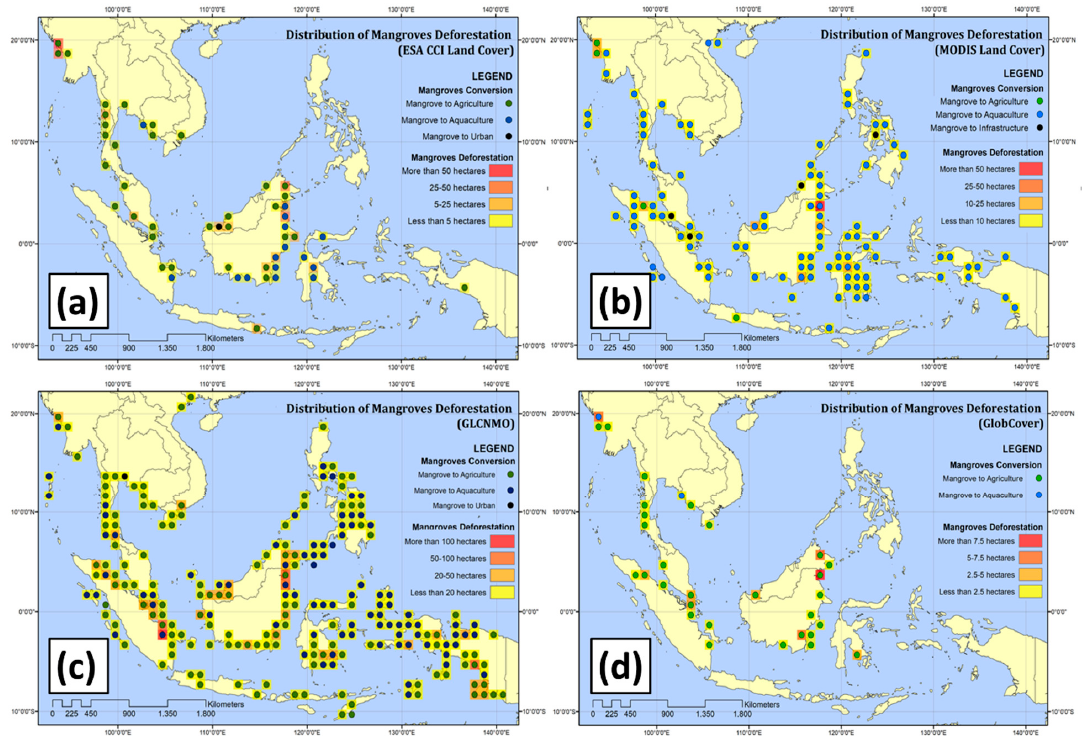
Figure 6. Distribution of land as the result of mangrove deforestation conversion and its quantity based on ( a ) ESA CCI Land Cover 2001 and 2012, ( b ) MODIS Land Cover 2001 and 2012, ( c ) GLCNMO 2008 dan 2012 and ( d ) GlobCover 2005 and 2009.